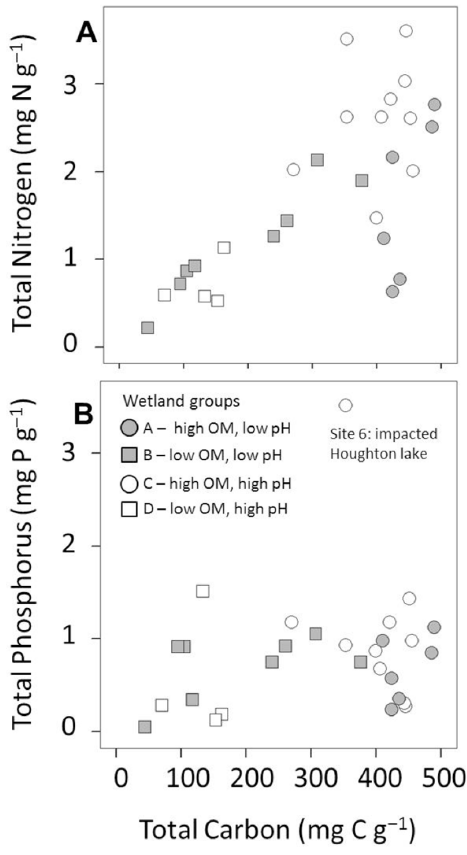
Figure 2. Mean total element concentrations in surface soils of 28 palustrine wetlands. Symbols represent wetland type, grouped by organic matter (OM) content and pH. Total carbon and ni- trogen showed significant positive correlation (Spearman’s rho = 0 . 67, p < 0 . 0001), which improved when only considering “low” C ( < 360mgCg − 1 ) sites (Spearman’s rho = 0 . 89, p < 0 . 0001). Total carbon and phosphorus showed no significant correlation (Spear- man’s rho = 0 . 20, p = 0 . 3). Note the high total P in the highly pol- luted Houghton Lake (site